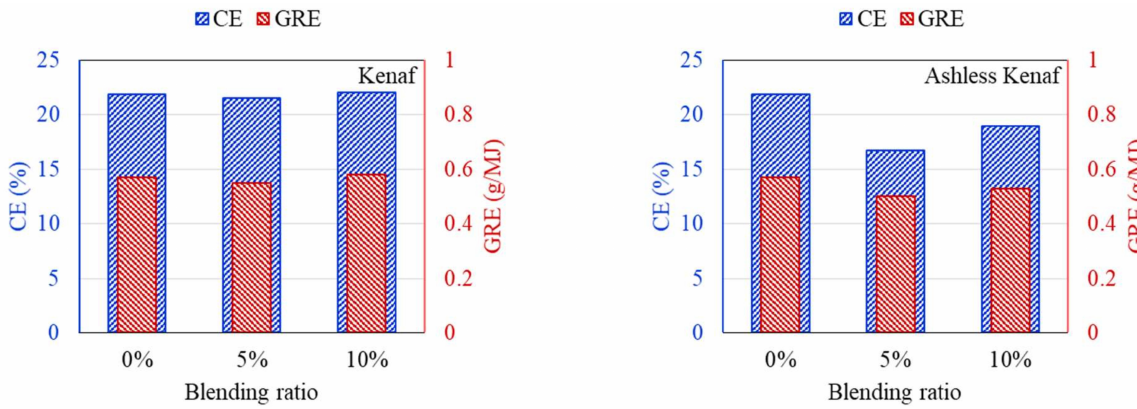
Figure 11. CE and GRE of cofiring different blends of the kenaf ( left ) and ashless kenaf ( right